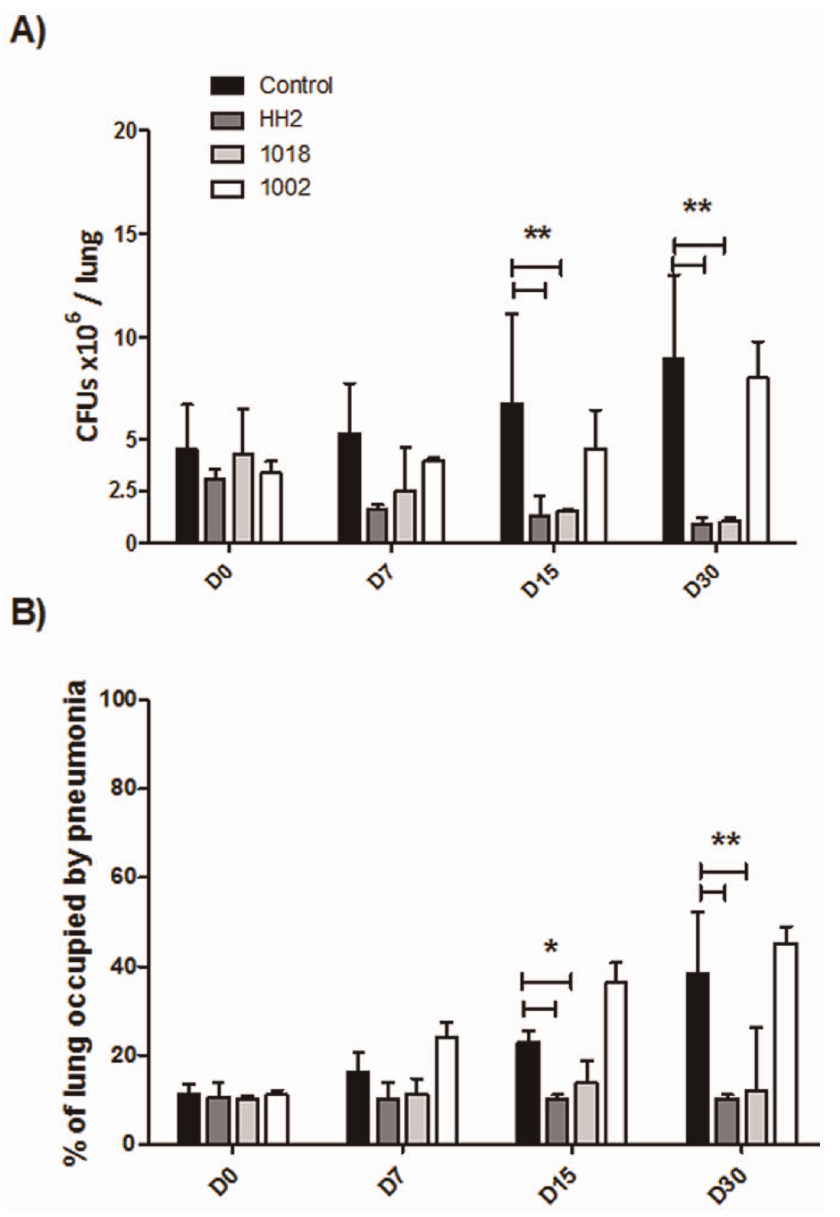
Figure 4. Effect of antimicrobial peptide treatment on pulmonary bacilli burdens and tissue damage (pneumonia) during experimental tuberculosis kinetic. (A) Mice were infected with the drug-sensitive H37Rv Mtb strain, and after 60 days were treated, three times per week, with , 1 mg/kg of the indicated peptide in 100 mL of saline solution. HH2 and 1018 decreased the lung bacillary loads in comparison with untreated mice, whereas 1002 showed no significant changes. (B) Percentage of the lung surface affected by pneumonia as determined by automated morphometry. Results are expressed as means 6 standard deviations, P , 0.05 * or P , 0.01** were considered statistically significant. Both 1018 and HH2 peptides significantly decreased the pneumonic area when compared with the control group. The graph is representative data from